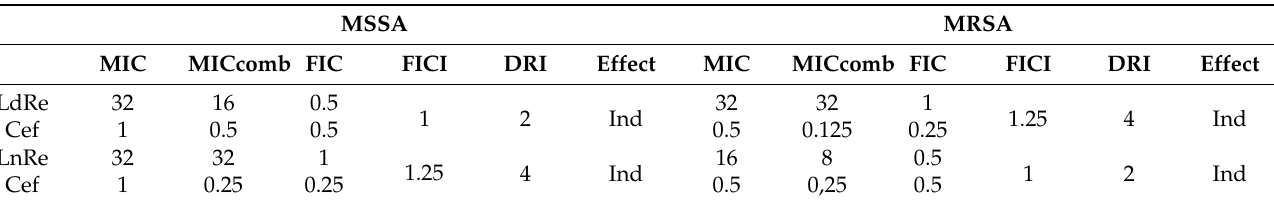
Table 5. Combinatory effects of LdRe and LnRe with cefotaxime. The results are showed as MIC and MIC combination ( MICcomb; expressed in μg /mL), fractional inhibitory concentration (FIC), fractional inhibitory concentration index (FICI) and dose reduction index (DRI) values.